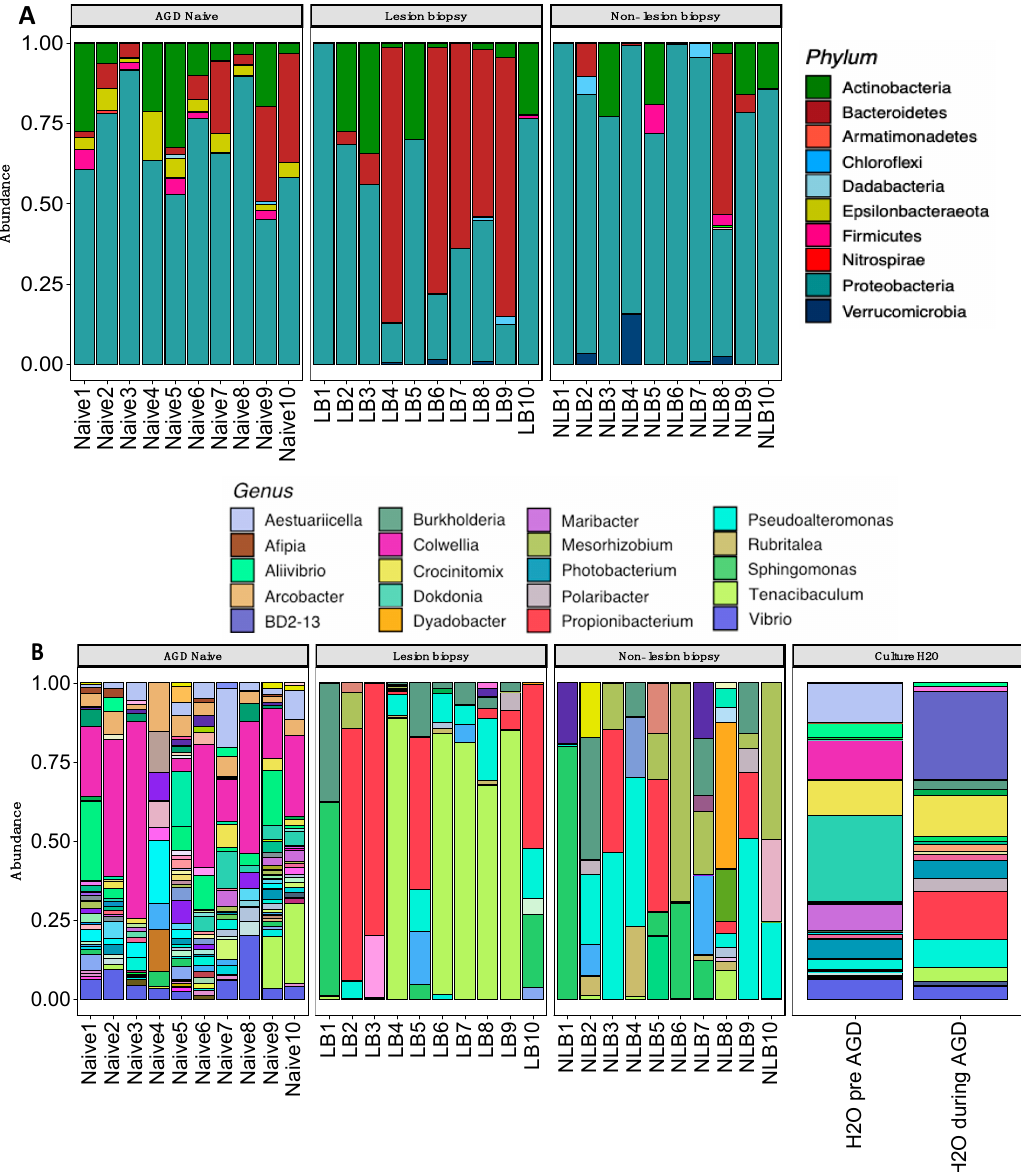
Figure 5. Microbial abundance of samples in this study. Plots show relative abundance (%) for Naïve, LB and NLB and fish at the phylum level ( A ) and Sterivex water samples at the genus level ( B ) level. Overall diversity of bacterial communities in the naive fish were higher, where AGD affected fish identified lower numbers of taxa with higher abundances.